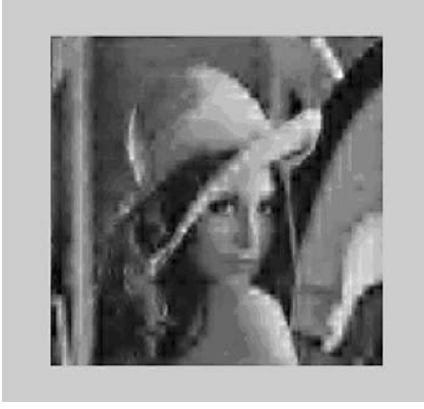
Figure 8: Denoised Lena image decomposed with the D4 scalar wavelet and thresholded with the univariate